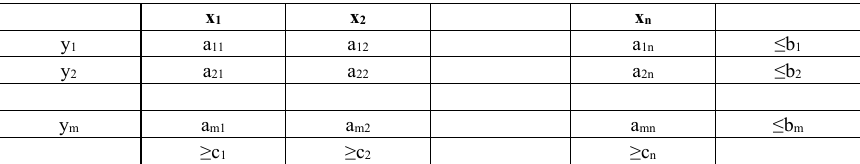
Table 2. Representation of dual